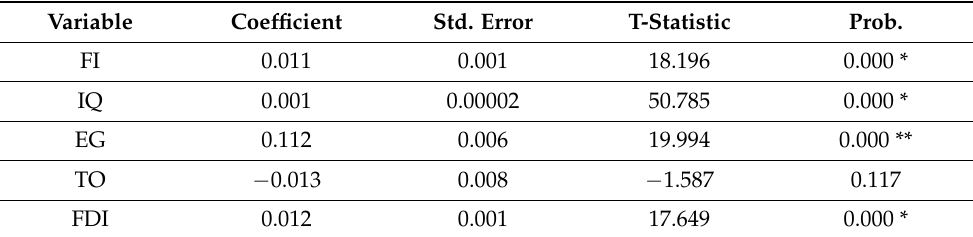
Table 4. Fully modified least squares